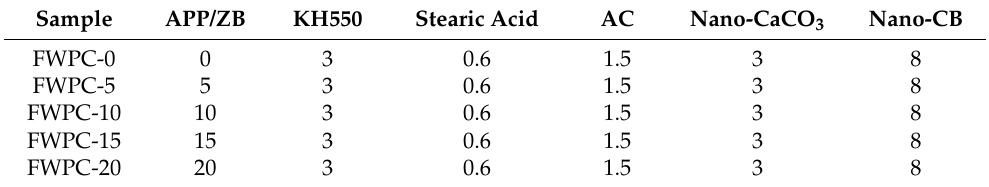
Table 1. Formula of Flame-Retardant and Antistatic Foamed Wood–Plastic Composite. Sample